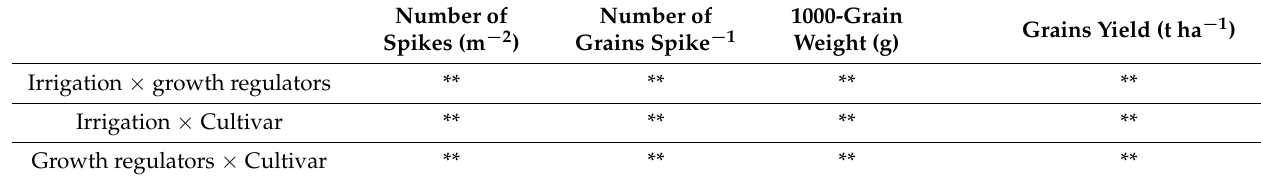
The mean squares of three first-order interactions of combinations between irrigation intervals, growth regulators and wheat cultivars on physiological and agronomical traits of